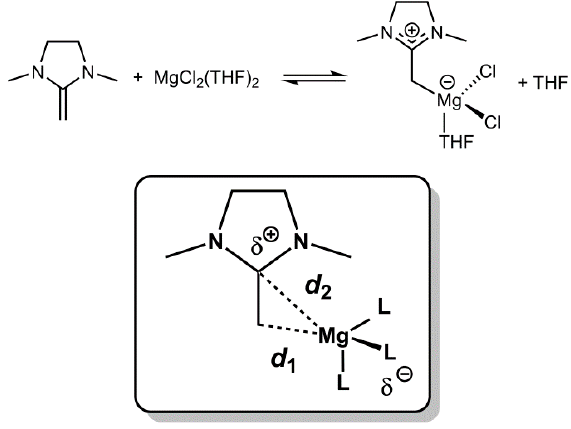
Table 1. Properties of the MgCl 2 (NHO)(THF) complexes.